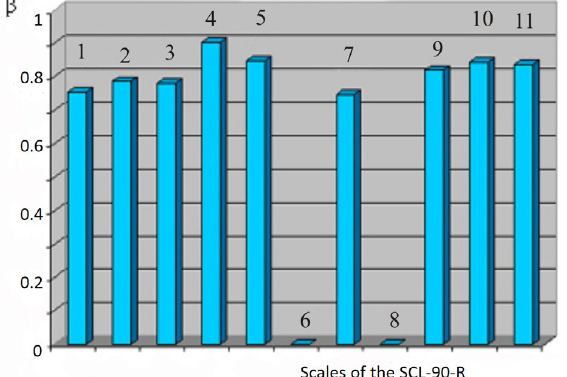
Figure 1. Standard regression coefficients for the SCL-90-R “General Severity Index Scale”. Notes: The ordinate is the standard regression coefficients (ß). On the abscissa axis of the scale 1—somati-